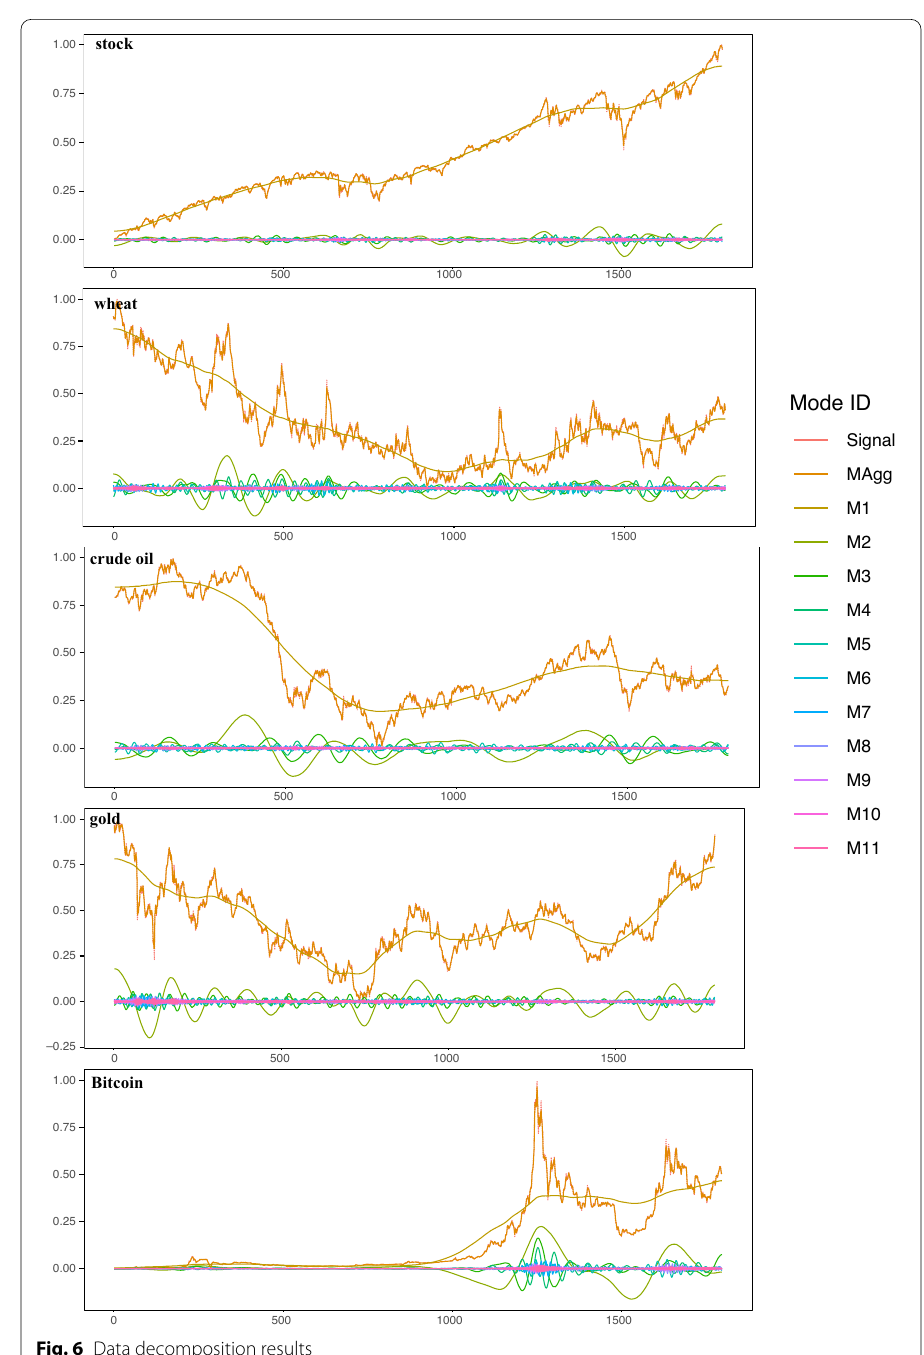
Fig. 6 Data decomposition